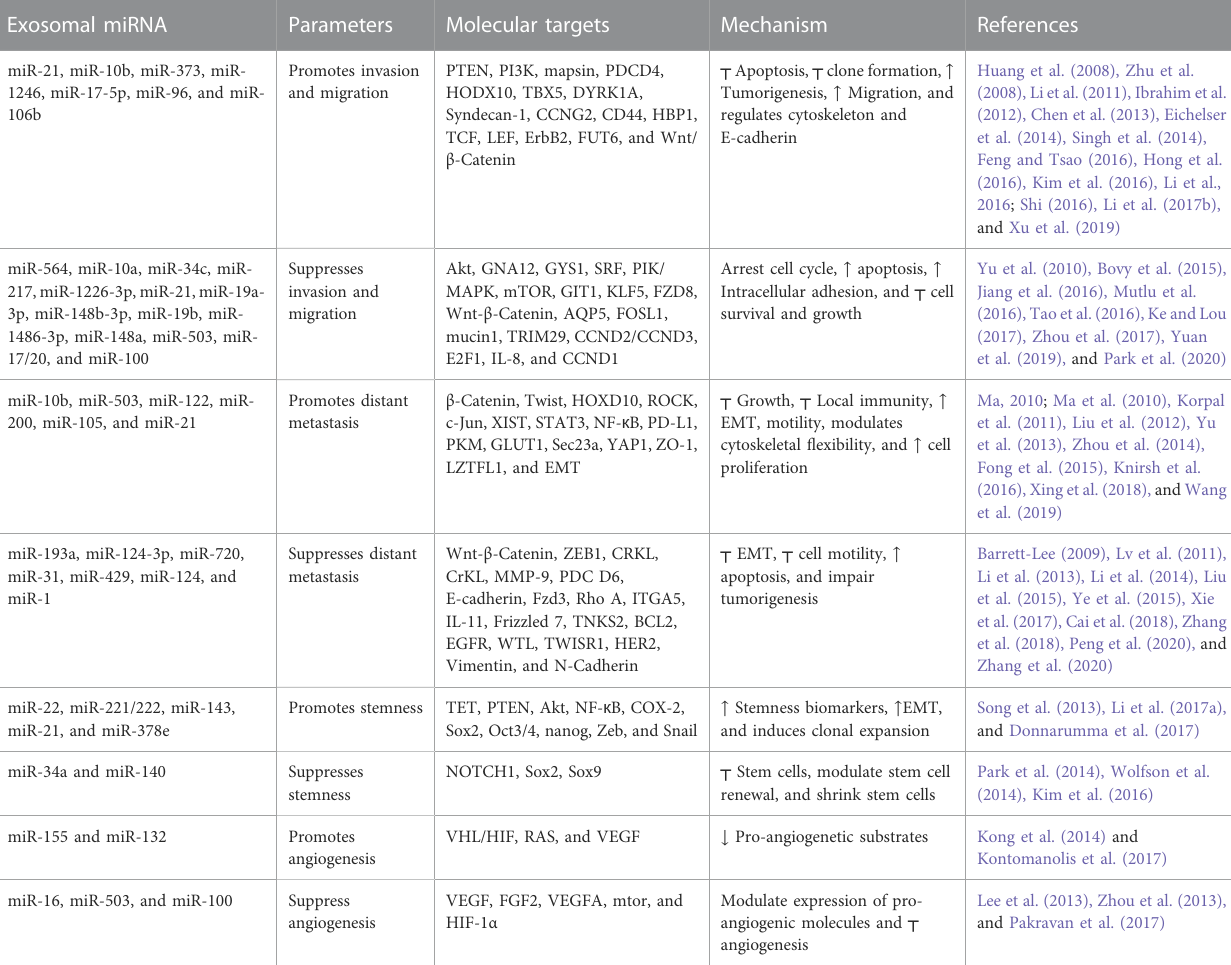
TABLE 2 Role of exosomal miRNAs in breast cancer invasion, migration, and